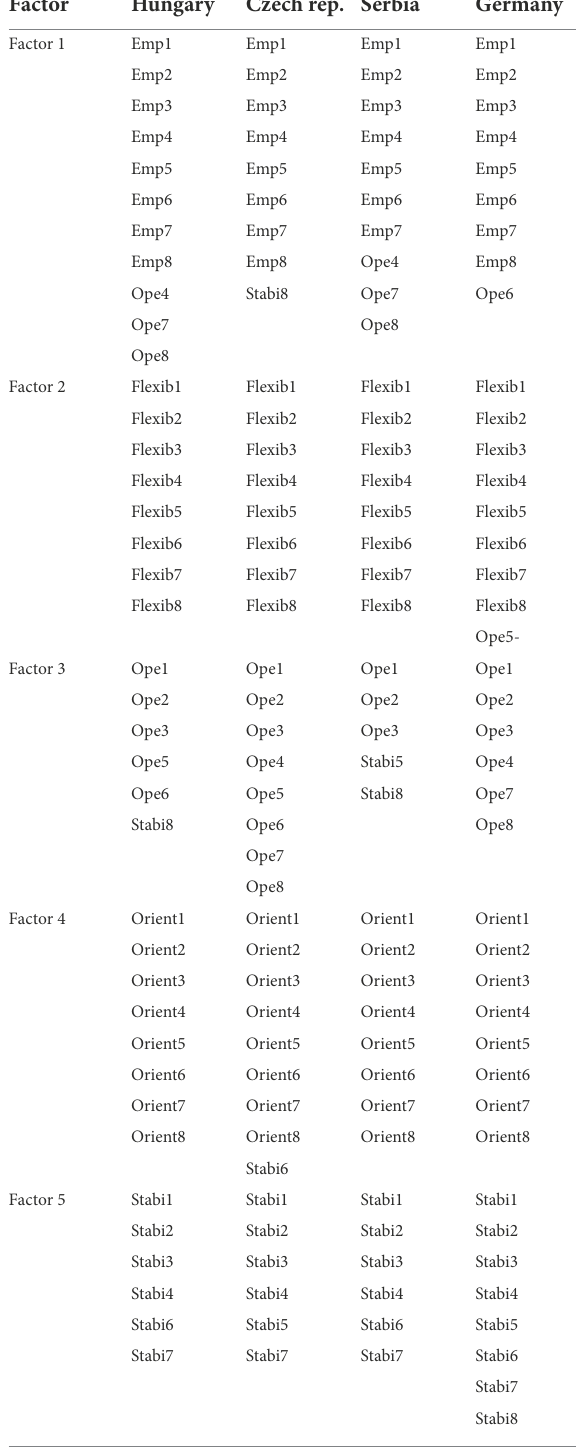
in the four samples. TABLE 3 Factor structure of the multicultural personality questionnaire compared between the subsamples.